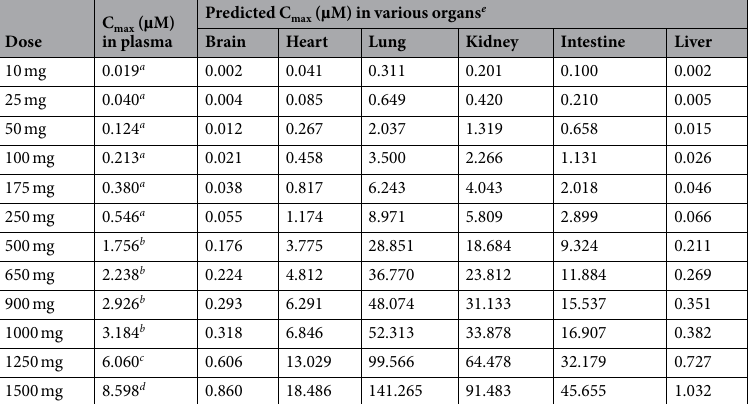
Table 2. C max ( µ M) of lapatinib in human plasma from clinical pharmacokinetic data and the predicted C max ( µ M) in various human organs associated with various doses. a Data in the row come from clinical trial by Bence et al . 38 . GW572016 ditosylate monohydrate formulated in oral suspension; b Data in the row come from clinical trial EGF10004, Lapatinib (GlaxoSmithKline, Research Triangle Park, NC) was supplied as 100-mg and 250- mg tablets for daily oral administration; c Data in this row come from clinical trial NCT00477464. Lapatinib was orally administered at 1250 mg once daily; d Data in the row come from clinical trial NCT00486954 and NCT01138046, 36 data points from 6 subgroups were combined for the average C max . Lapatinib was in 6 pills at 250 mg each once oral daily; e All of the predicted C max values are calculated based on the ratios of the drug concentrations in various organs to that in plasma in rats reported in literature 56